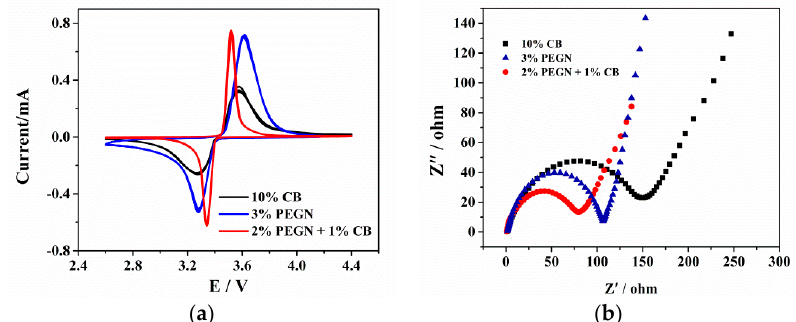
Figure 7. ( a ) Cyclic voltammetry (CV) profiles and ( b ) electrochemical impedance spectroscopy (EIS)